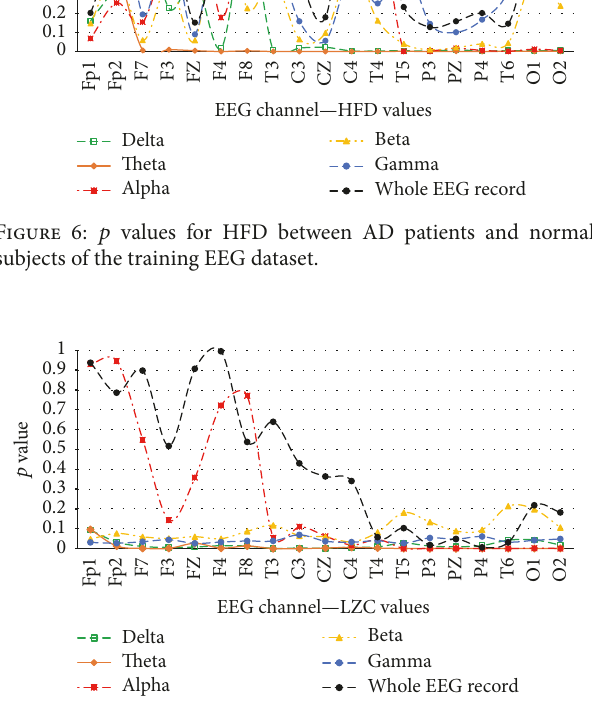
Figure 7: 𝑝 values for LZC between AD patients and normal subjects of the training EEG